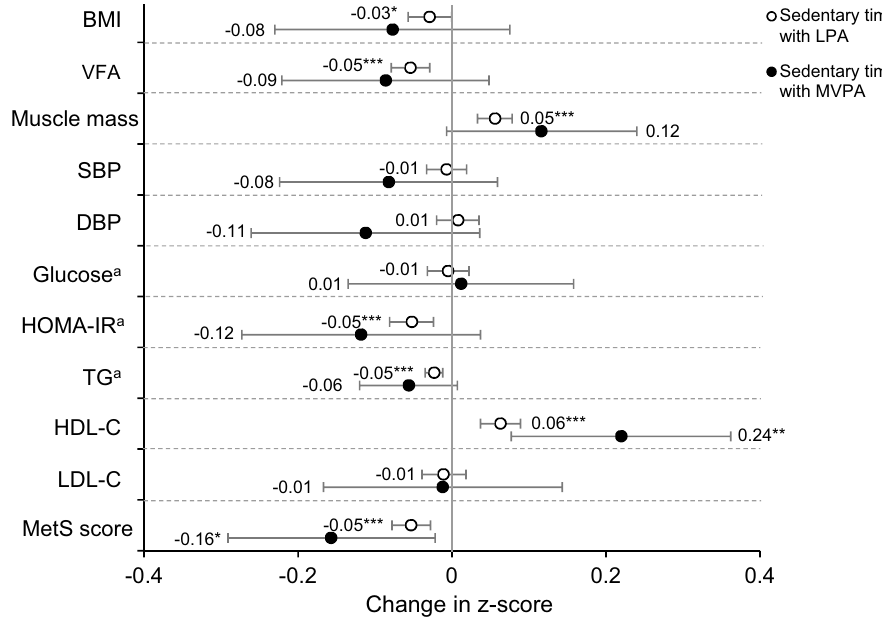
Figure 1. Isotemporal substitution of sedentary time with LPA or MVPA on cardiometabolic risk factors. The values shown are β (95% confidence interval). Each z-score indicates the amount of change in the outcome variable associated with reallocating 30 min of sedentary time to LPA (open circle) or MVPA (closed circle). Abbreviations: BMI, body mass index; VFA, visceral fat area; SBP, systolic blood pressure; DBP, diastolic blood pressure; HOMA-IR, homeostasis model assessment of insulin resistance; TG, triglycerides; HDL-C, high- density lipoprotein cholesterol; LDL-C, low-density lipoprotein cholesterol. Linear regressions models were used to assess isotemporal substitution of sedentary time with LPA or MVPA, with adjustment for age, sex, smoking status, alcohol intake, energy intake, and accelerometer wear time. a Log-transformed value was used. The MetS score was calculated by standardising and summing VFA, blood pressure ([SBP + DBP]/2), log glucose, log TG, and inverse HDL-C. * P < 0.05, ** P < 0.01, *** P <